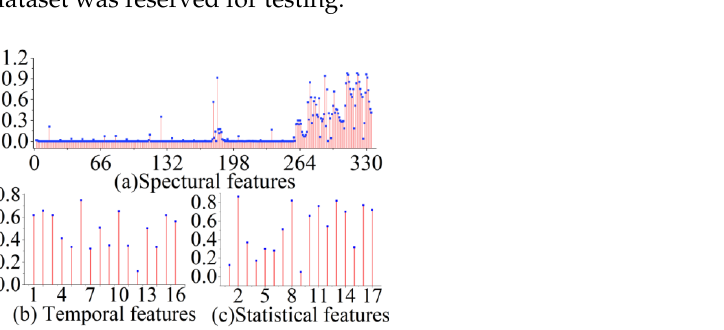
Figure 4. Extracted features from different aspects after normalization. ( a ) 334 spectral features, ( b ) 16 temporal features, and ( c ) 17 statistical